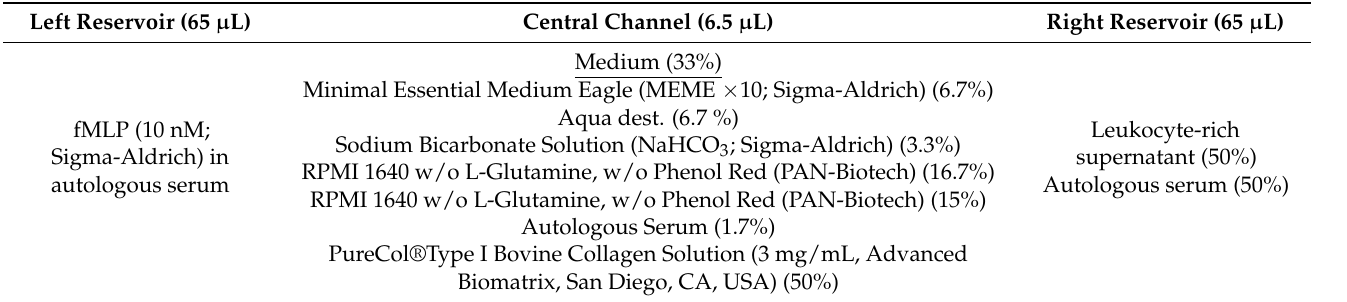
Table A1. Detailed composition of the 3D- µ -Slide’s